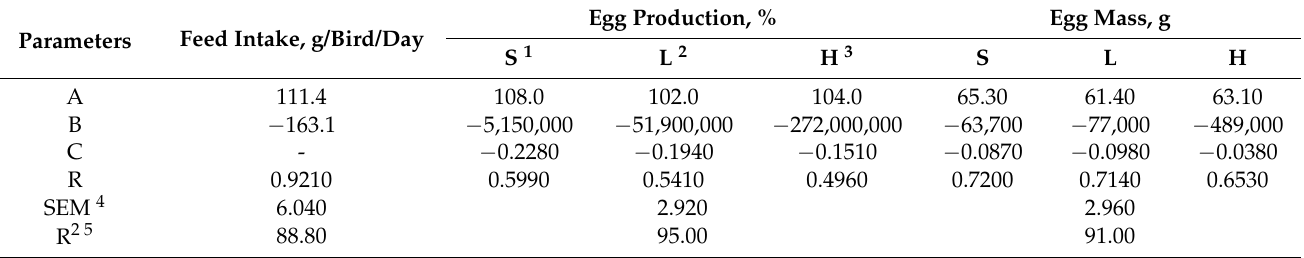
Table 5. Coefficients from an exponential equation for feed intake of laying hens from 8 to 102 weeks old and coefficients from a linear plus exponential equation for egg production and egg Mass of laying hens from 19 to 102 weeks old in response to age in three dietary balanced protein